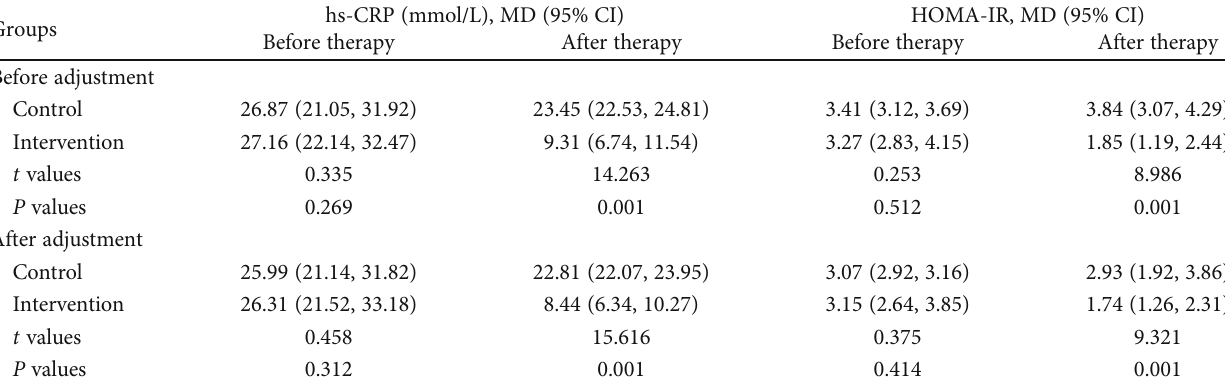
Table 8: The comparison of hs-CRP and HOMA-IR between two groups before and after adjusting for confounders (age, BMI, and HbA1c).